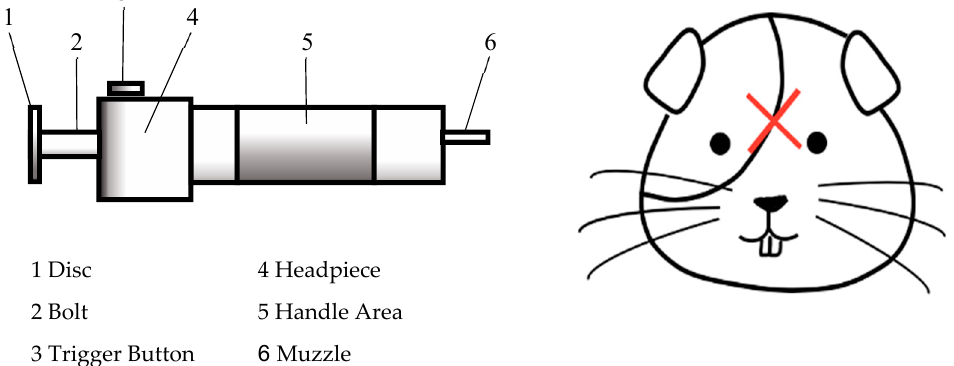
Figure 2. ( Left ): ‘ The Ballista ’ spring-powered non-penetrating captive bolt. ( Right ): The red cross denotes where the captive bolt was positioned on the guinea pigs.